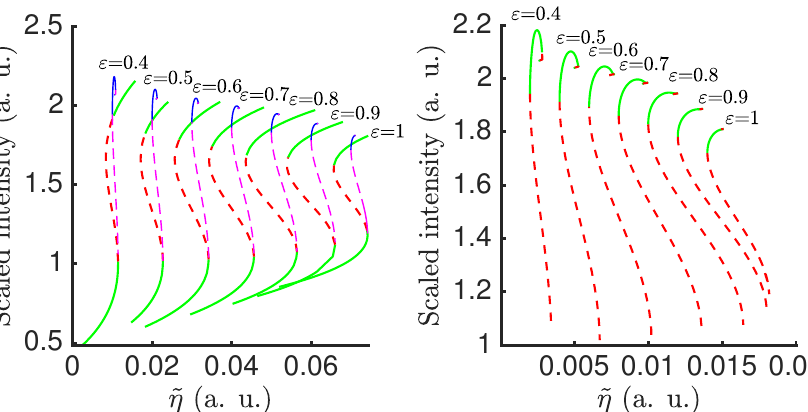
Figure 9. CW states cut around S-shaped bifurcation curve (thick lines) and periodic solutions (thin lines) of (12), where solid lines represent stable states and dashed lines represent unstable states. Right panel: Branches of periodic solutions from the left panel, magnified. The intensity is scaled by ε 2 , the curves from left to right correspond to j = 5,6,7,8,9,10,11, and other parameters are as in Figure 8.